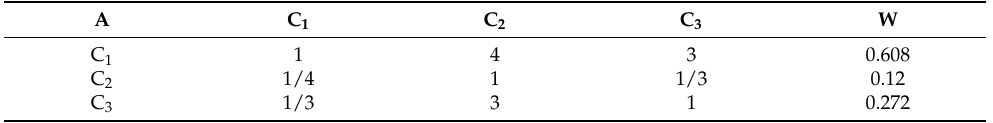
Table 6. The results of matrix and its consistency test between Target layer(A) and Constraint layer (C 1 –C 3 ).